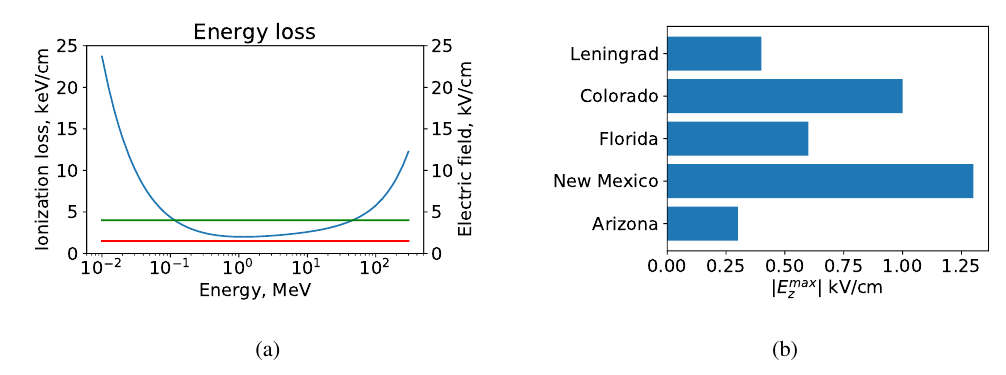
Figure 1: a) Gurevich model: if electric field is higher than MIP loss (green line) there are possible to generate runway electron, otherwise (red line) avalanches are discharged [1]. b) Extremal value of vertical electric field (before 1989 y.)